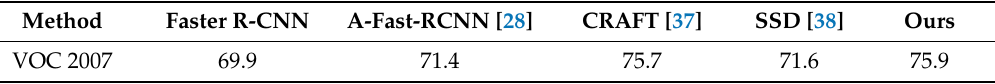
Table 2. A comparison between the proposed method with the existing models on the dataset, PASCAL VOC